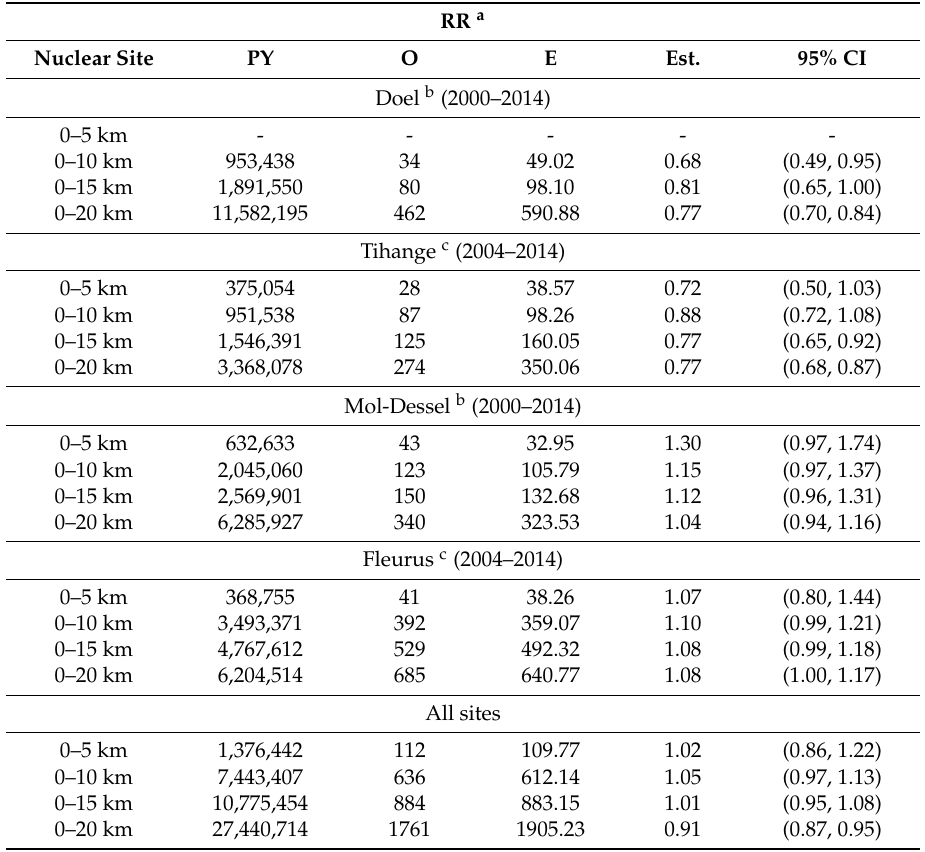
Table 1. Rate ratios of thyroid between 2000 (2004) and 2014 for the 0–5, 0–10, 0–15, and 0–20 km proximity area around each nuclear site and the four Belgian nuclear sites